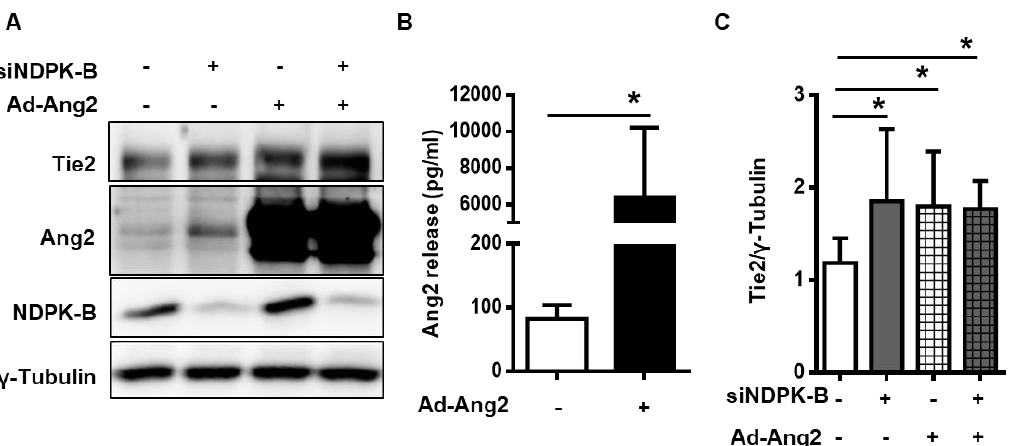
Figure 6. An excess of secreted Ang2 promotes the upregulation of Tie2. HUVECs were transfected with either scrambled control ( − ) or siRNA against NDPK-B (siNDPK-B, + ) and infected with an Ang2 encoding adenovirus (Ad-Ang2, + ) or Ad-GFP ( − ) as control. ( A ) Representative immunoblots of Tie2, Ang2, NDPK-B, and γ -Tubulin in NDPK-B depleted cells with and without Ang2 overexpression. ( B ) Quantification of secreted Ang2 in cells without and with Ang2 overexpression (Ad-Ang2, n = 4). ( C ) Quantification of Tie2 normalized to γ -Tubulin ( n = 6). * p < 0.05.